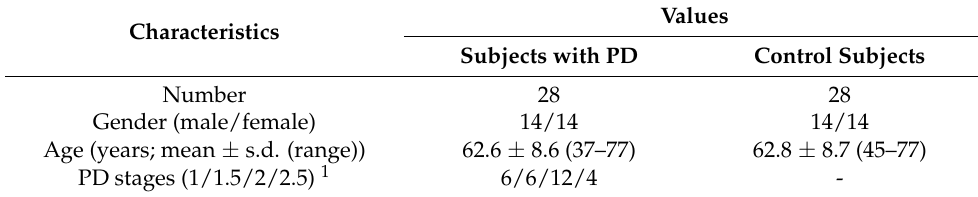
Table 3. Study cohort characteristics.